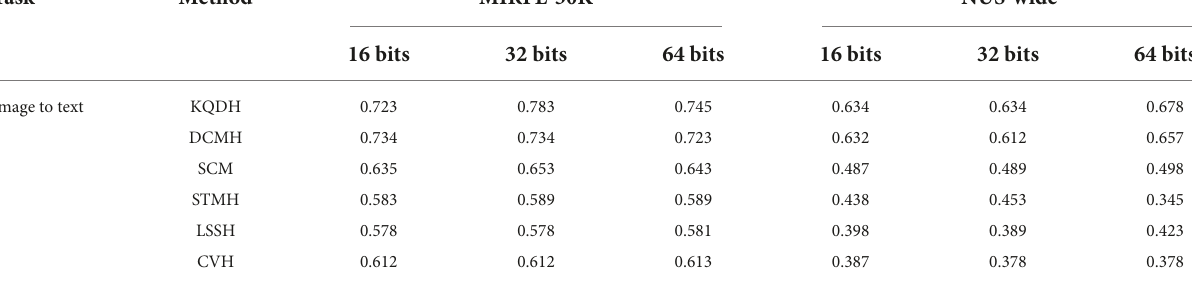
TABLE 4 Average accuracy (RP) of each